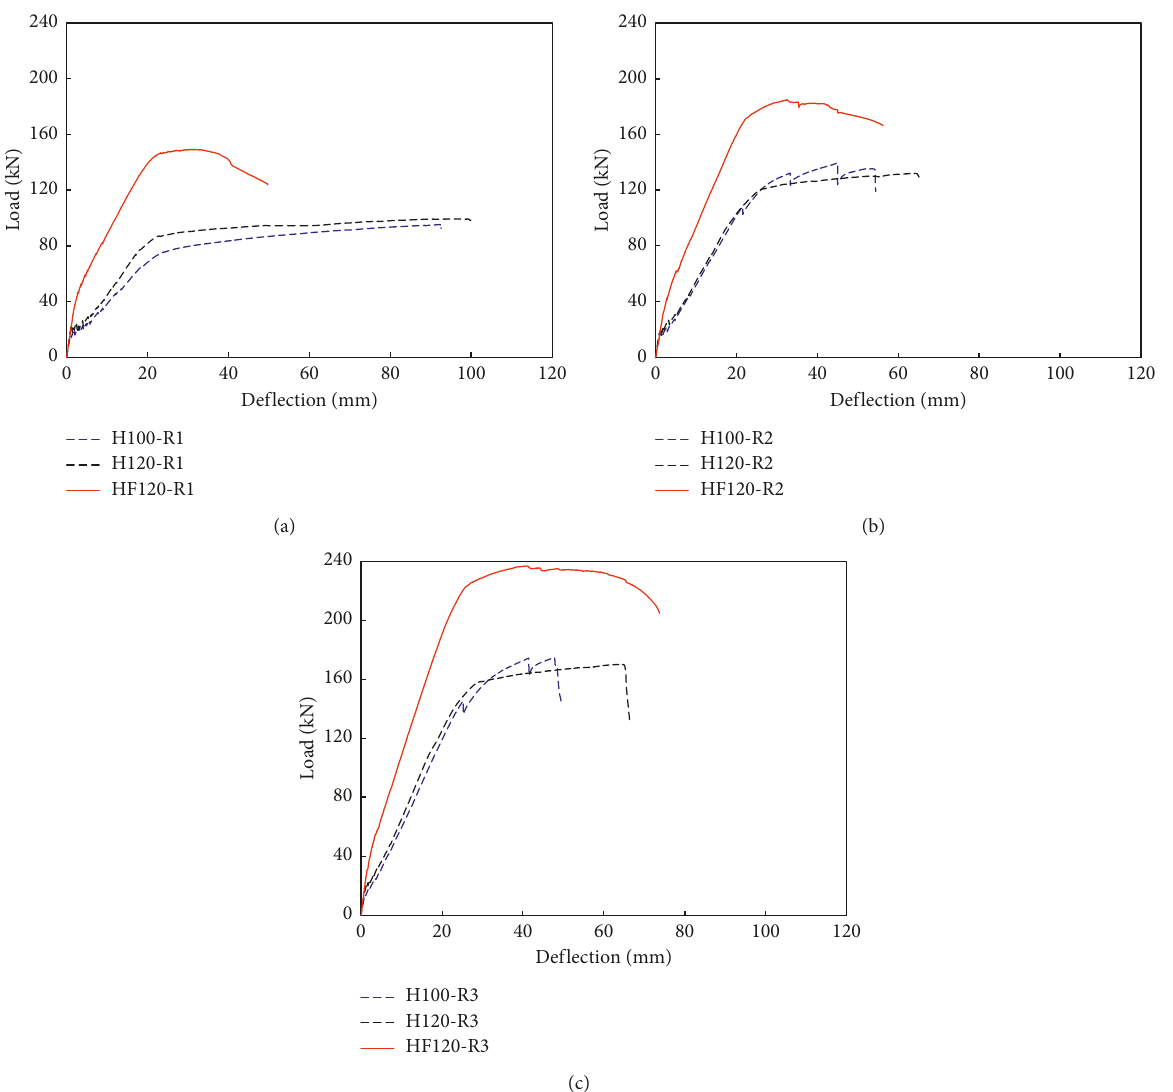
Figure 9: Load-deflection curves for different types of concrete. (a) Rebar ratio of 0.98%. (b) Rebar ratio of 1.47%. (c) Rebar ratio of 1.97%.